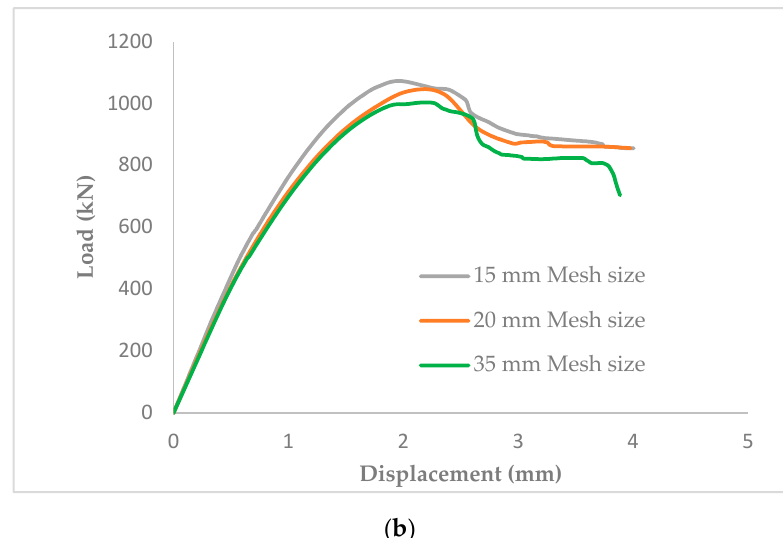
Figure 7. Mesh sensitivity analysis: ( a ) mesh configurations and ( b ) load vs. displacement results for the different element sizes.